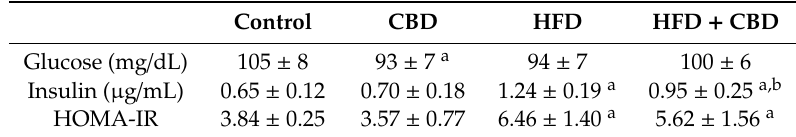
Table 1. Plasma glucose and insulin levels, as well as homeostatic model assessment for insulin resistance (HOMA-IR), after chronic cannabidiol (CBD) administration in rats fed standard (control group) and high-fat diets (HFD). The data are expressed as mean values ± SD, n = 10 in each group. a p < 0.05 significant di ff erence: control group vs. examined group; b p < 0.05 significant di ff erence: HFD vs. HFD +